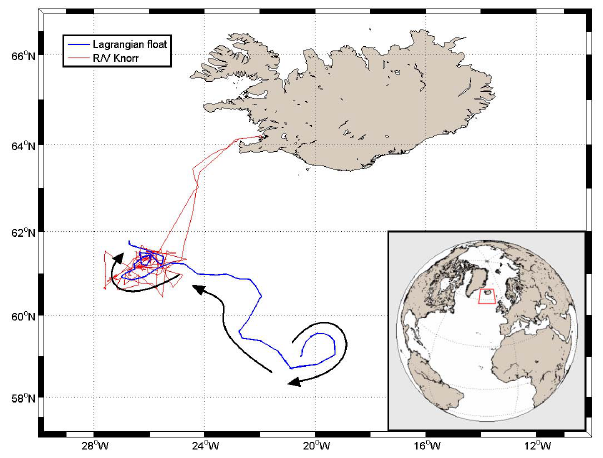
Fig. 1. Location of the NAB08 experiment. Path of the Lagrangian float is shown in blue. R/V Knorr cruise track is shown in